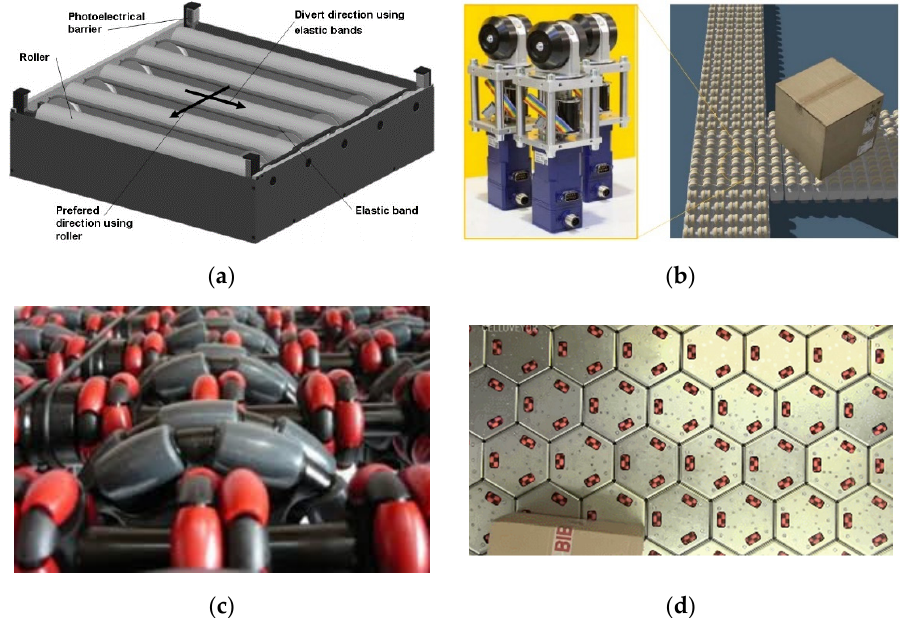
Figure 3. Physical appearance of: ( a ) Flexconveyor [1], ( b ) small-scaled conveyor module (SCM) with servo driven swelling roller [14], ( c ) conveyor platform that comprises big and small omniwheels (BSO) [8], ( d ) Celluveyor [2].